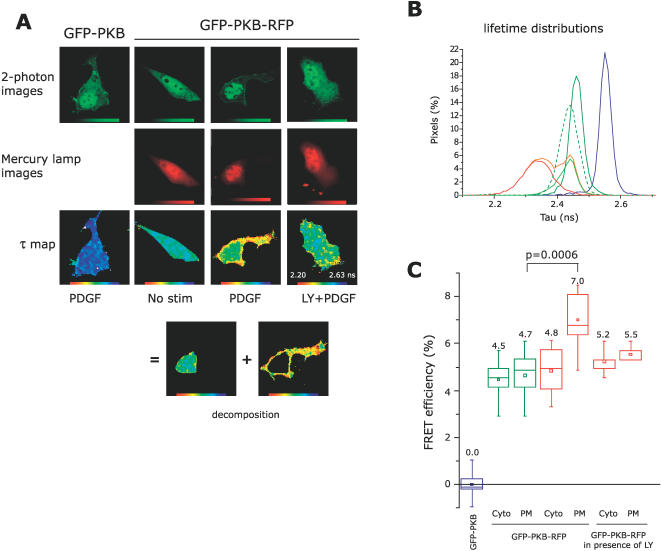
Phosphoinositide-Dependent Change in PKB Conformation at the Plasma Membrane(A) NIH3T3 cells were transfected either with GFP-PKB or GFP-PKB-RFP. Upon PDGF treatment, GFP-PKB-RFP translocated to the plasma membrane and changed in conformation. The lifetimes are represented in pseudo-colour scale ranging from 2.20 to 2.63 ns. As indicated, the cells were pretreated for 20 min with LY294002 before PDGF stimulation. LY294002 prevented the translocation of GFP-PKB-RFP to the plasma membrane and its change in conformation but did not affect the FRET efficiency in the cytoplasm.(B) The lifetime distributions are shown on the graphs: GFP-PKB control (blue), GFP-PKB-RFP (green), and GFP-PKB-RFP upon PDGF (orange) and treated with LY294002 before PDGF stimulation (dashed green). The separation of the lifetime pixels at the plasma membrane (red) and cytoplasm (light green) is shown for GFP-PKB-RFP upon PDGF stimulation.(C) The statistical analysis presented as box and whiskers plots shows the extremely significant change in FRET efficiency (p = 0.0006) of GFP-PKB-RFP before and upon PDGF stimulation at the plasma membrane (PM) and the loss of FRET change when pretreated with LY294002.